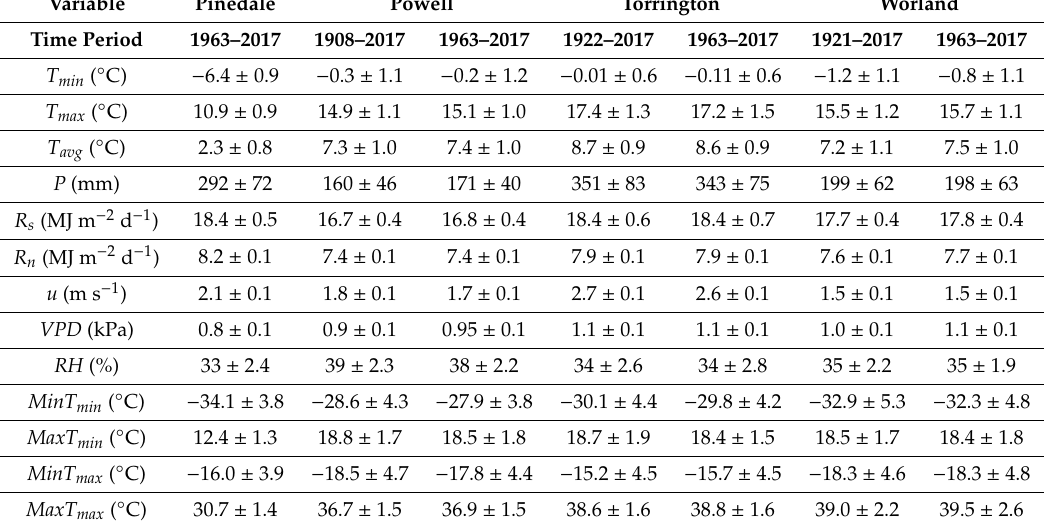
Table 2. Average values with standard deviation for climate variables used in this study from four weather stations over the period-of-record and from 1963–2017. T min , T max , and T avg = minimum, maximum, and average air annual temperature, respectively ( ◦ C); P = average annual precipitation (mm); R s and R n = average annual incoming shortwave radiation and net radiation, respectively (MJ m − 2 d − 1 ); u = average annual wind speed at 2 m height (m s − 1 ), VPD = vapor pressure deficit